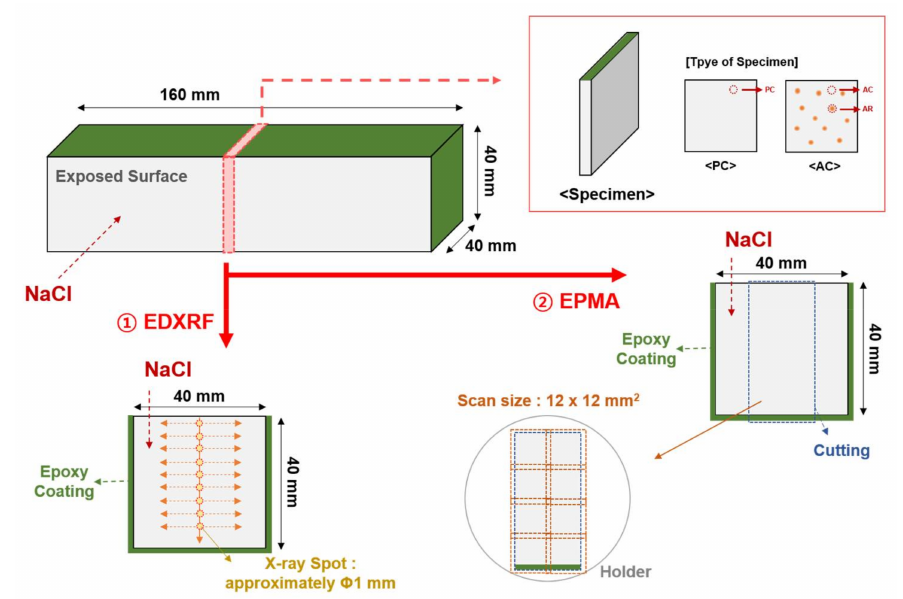
Figure 2. Outline of the sample preparation for X-ray analysis: EDXRF and